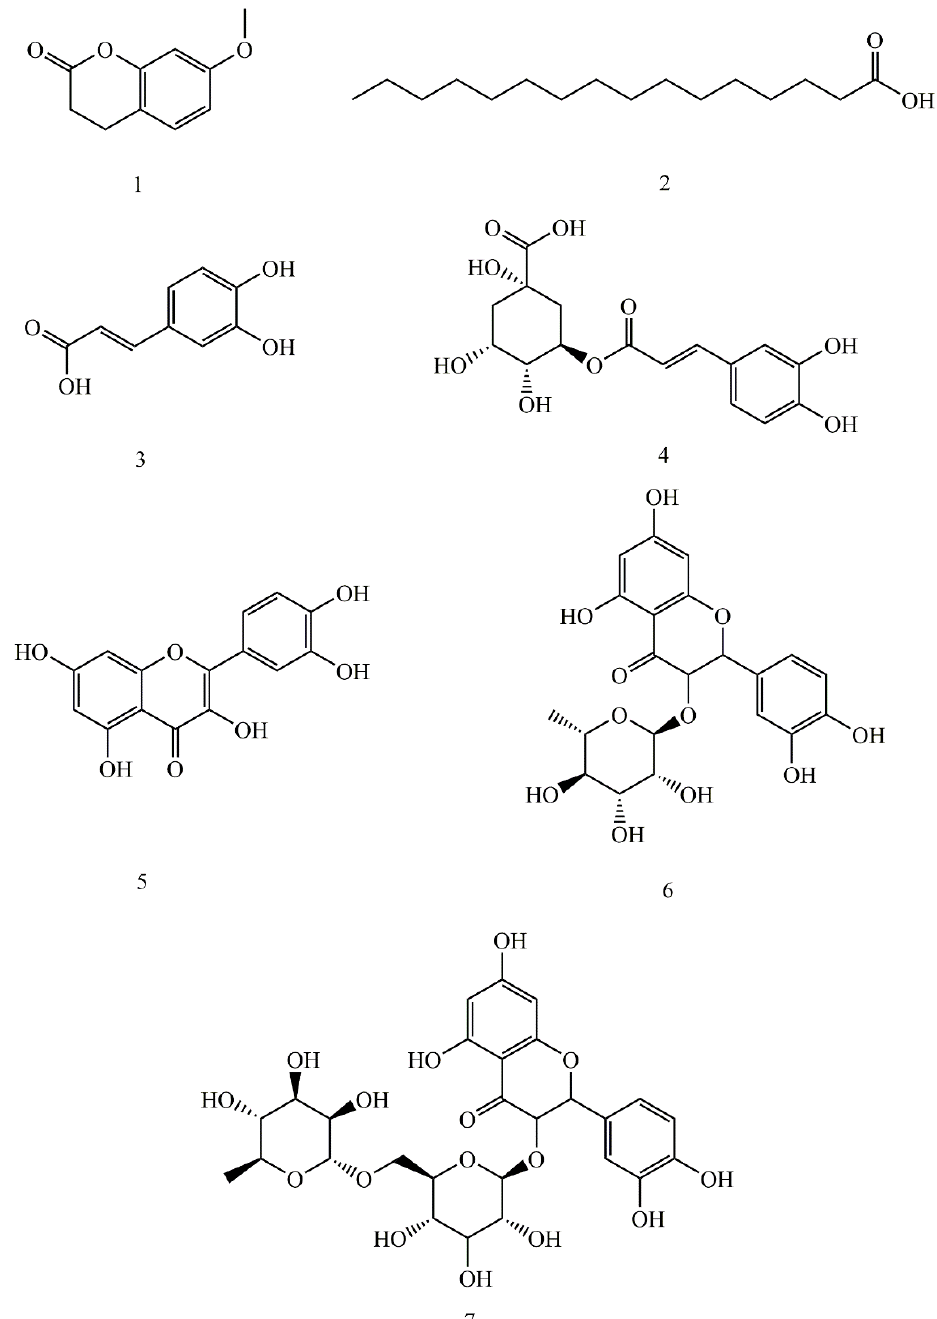
Figure 2. Structures of compounds 1 – 7 isolated from the rhizosphere soil of potato. ( 1 . 7-methoxycoumarin, 2 . palmitic acid, 3 . caffeic acid, 4 . chlorogenic acid, 5 . quercetin dehydrate, 6 . quercitrin, and 7 . rutin). Compound 1 : C 10 H 8 O 3 MS: [M + Na] + C 10 H 8 NaO 3 , measured m/z 199.0363, calculated m/z 199.0371, err 3.9 ppm.